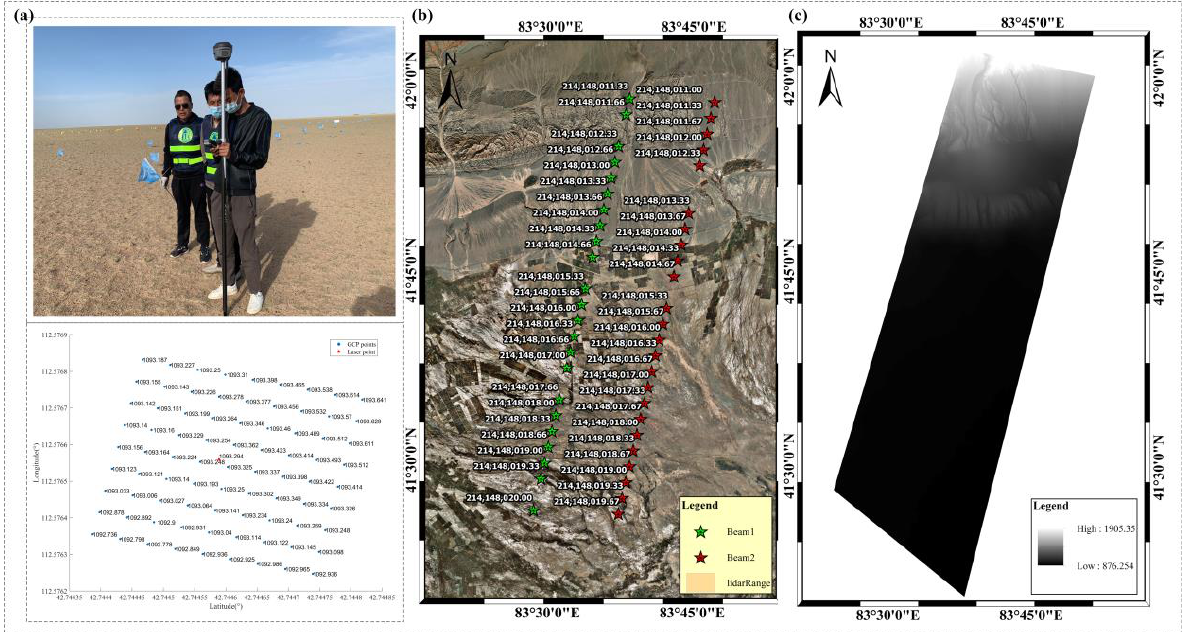
Figure 3. Distribution of different types of verification data. ( a ) RTK data. ( b ) Extrapolated laser data distribution. ( c ) High-precision airborne LiDAR data.